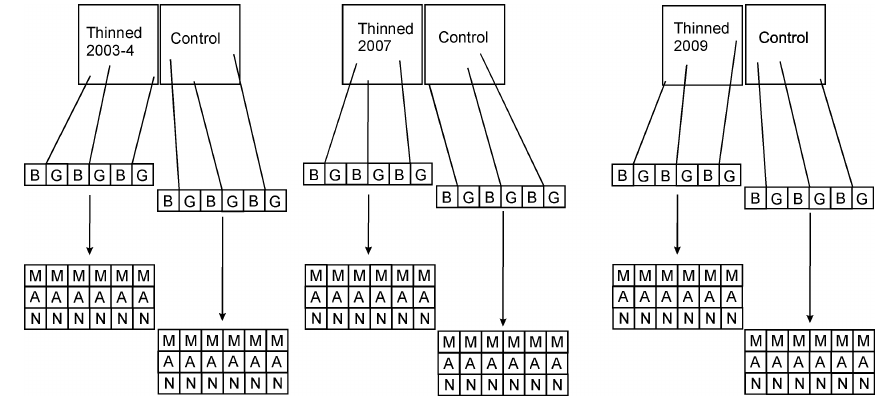
Figure 2. Experimental design. B, bush; G, grass; M, May 2012; A, August 2012; N, November